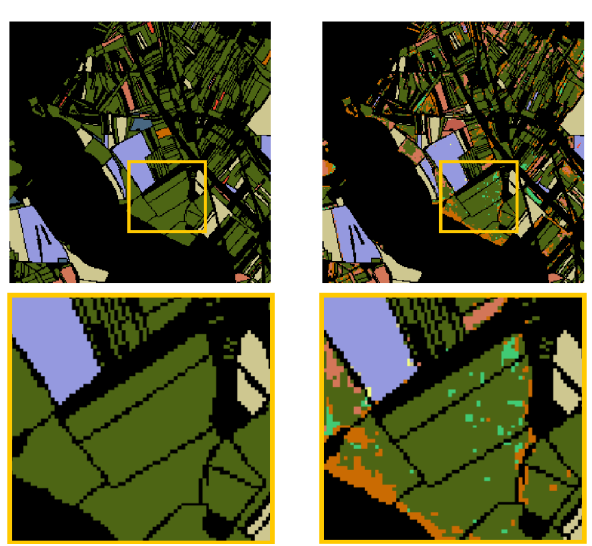
Figure 7. Reference on the left and result of TempCNN on the